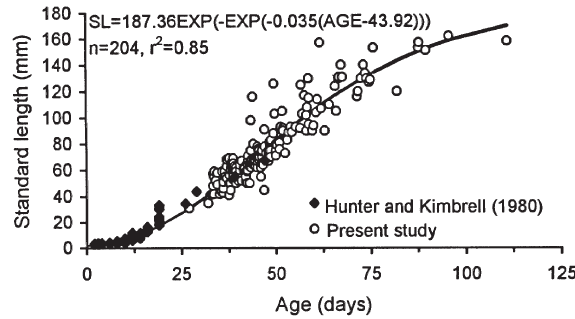
F IG . 6. – Gompertz growth curve fitted to length and age data for Pacific mackerel, Scomber japonicus . The thin portion of the Gompertz growth curve represents the projected